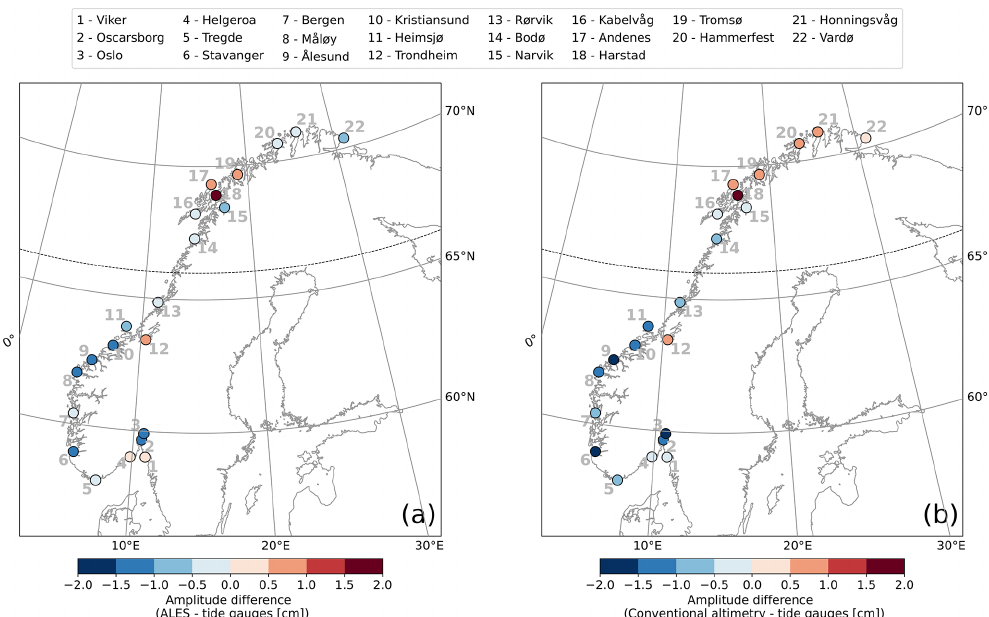
Figure C3. At each tide gauge location, difference between the amplitude of the sea-level annual cycle estimated from the ALES-reprocessed satellite altimetry dataset and from the tide gauge (a) , as well as from the conventional altimetry dataset and from the tide gauge (b) . The black dashed line indicates the 66 ◦ N